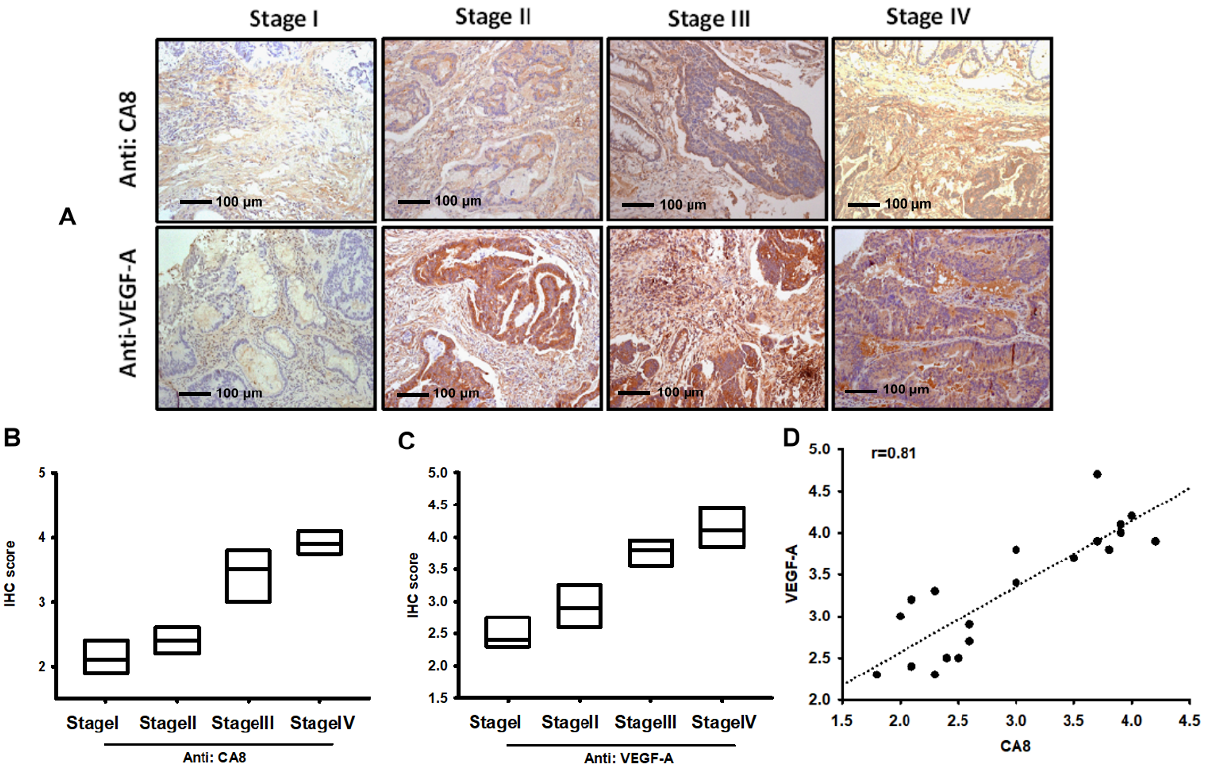
Figure 1. The correlation of CA-8, VEGF-A, and tumor grades in human colorectal cancer (CRC) tissues. IHC of CAVIII and VEGF-A ( A – C ) expressions in Stage I ( n = 3), Stage II ( n = 4), Stage III ( n = 6), and Stage IV ( n = 4) CRC tissues. The correlation and quantitative data are shown in ( D ).